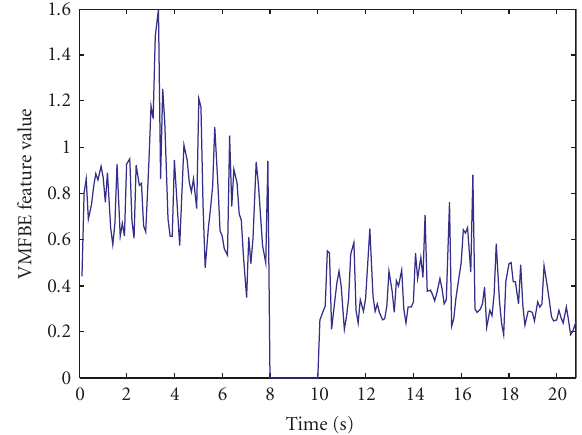
Figure 2: Visual representation of the energy filter bank variance coe ffi cients (0–8 seconds speech, 8–10 seconds silence and 10–20 seconds music).